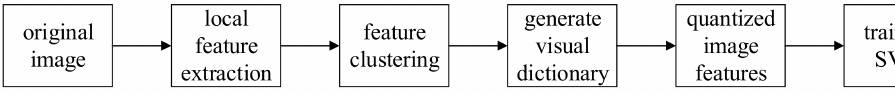
Figure 1. Flow chart of Bag of Visual